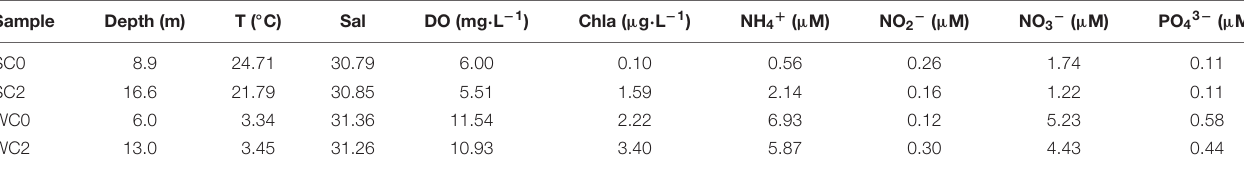
FIGURE 1 | Location of sampling stations in adjacent waters of Rushan Bay, China. TABLE 1 | The environmental factors at the sampling stations.